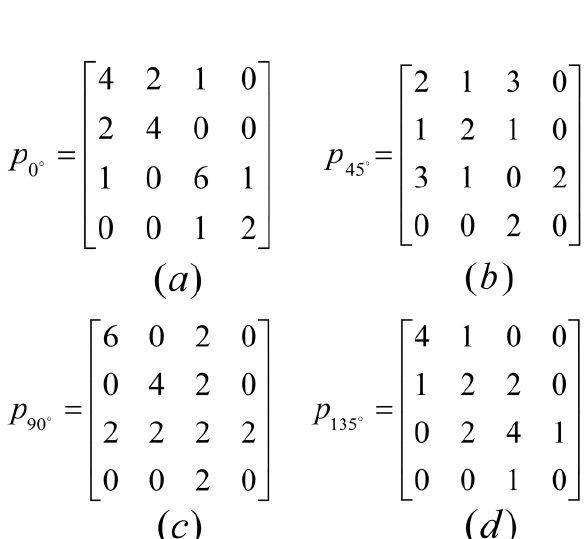
Table 3. Example symbol